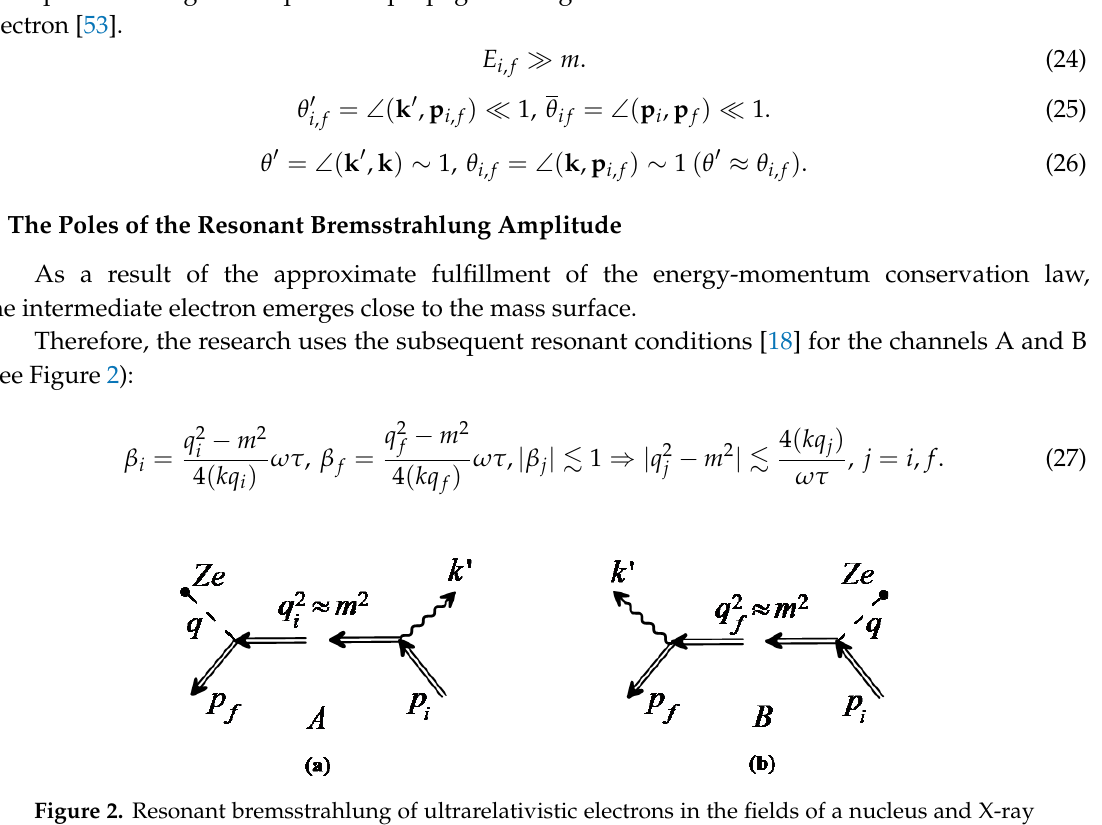
Figure 2. Resonant bremsstrahlung of ultrarelativistic electrons in the fields of a nucleus and X-ray pulsar. ( a ) Diagram A corresponds to the channel A. ( b ) Diagram B corresponds to the channel